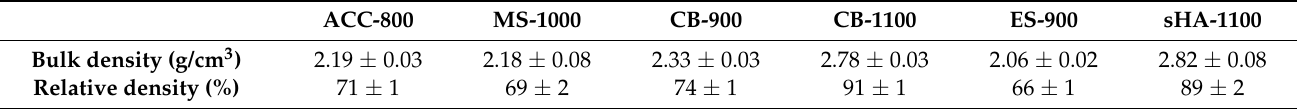
Figure 3. SEM images of the sintered materials: fracture surfaces ( a – c , g – i ); external surfaces that come into contact with the cells ( d – f , j – l ). Table 4. The bulk and relative density of the sintered pellets.